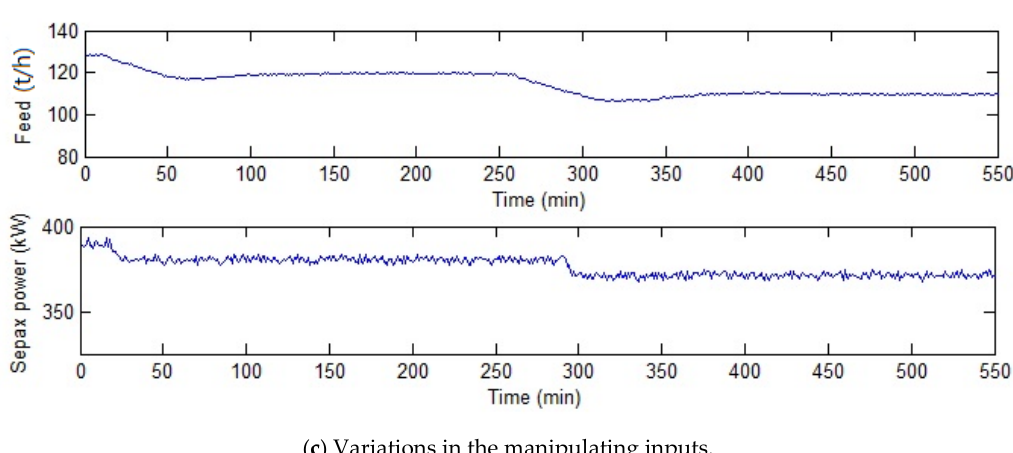
Figure 6. Variations in the different process and manipulating variables when SSMPC is implemented in the real-time cement plant simulator.